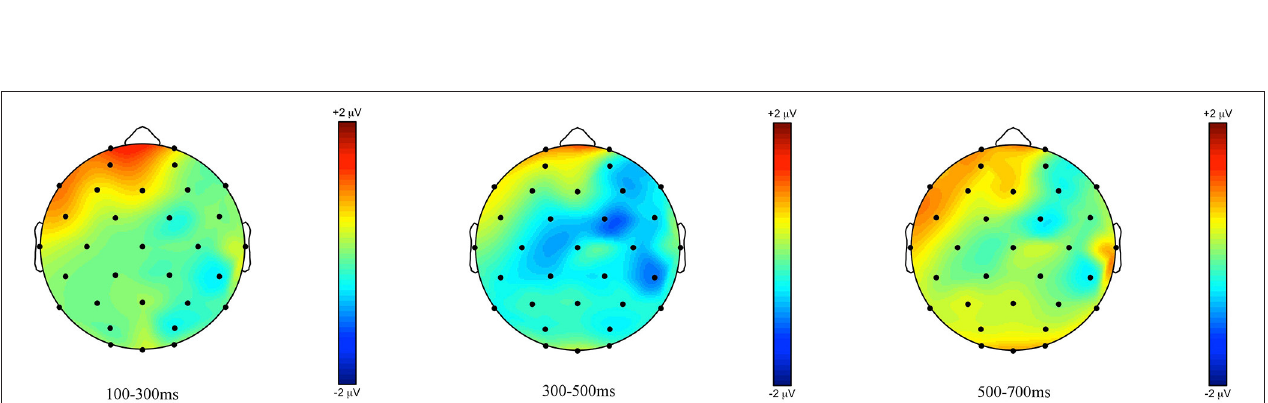
FIGURE 6 | Topographic maps of the ERPs recorded in adults, time-locked to the presentation of the word “Alle” ( all ) for the some -felicitous condition minus the some -infelicitous condition in the three time windows.